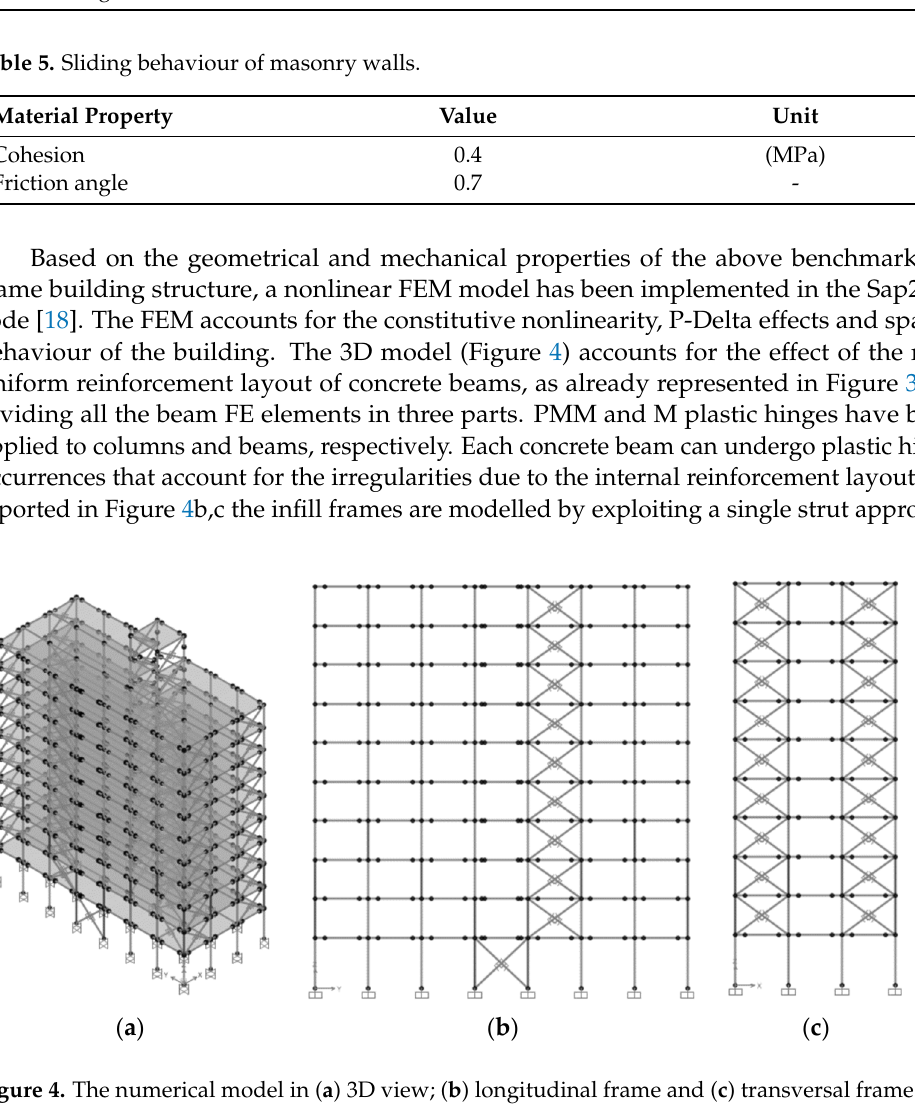
Figure 4. The numerical model in ( a ) 3D view; ( b ) longitudinal frame and ( c ) transversal